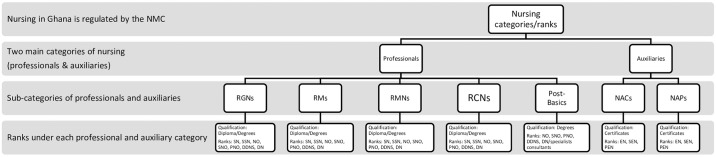
Categories and ranks of clinical nurses in Ghana.NMC (Nursing and Midwifery Council); RGNs (registered general nurses); RMs (registered midwives); RMNs (registered mental nurses); RCNs (registered community nurses); NACs (nurse-assistant clinicals); NAPs (Nurse-assistant preventive); EN (enrolled nurse); SEN (Senior enrolled nurse); PEN (principal enrolled nurse); Post-basics (these are specialized post-basic diploma or first degree courses and in some cases post-graduate specialist courses at the Ghana college of Nurses and Midwives; Courses under the category of post-basics include: public health nursing, ear-nose and throat nursing, critical and emergency case nursing, perioperative and theatre nursing, ophthalmic nursing, midwifery).